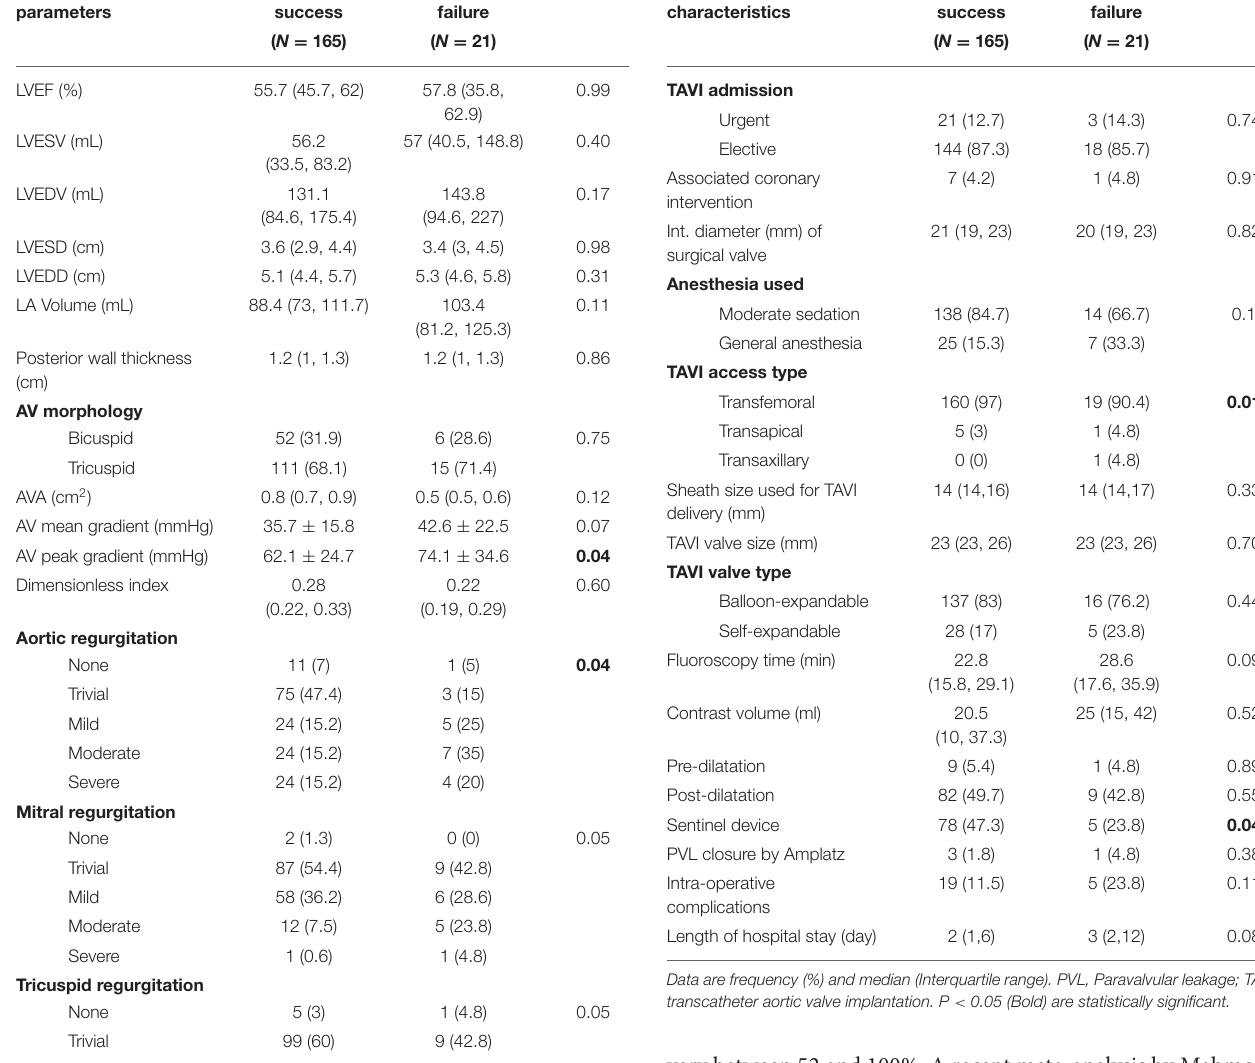
TABLE 2 | Echocardiographic parameters of patients in the procedural success and failure groups. Echocardiographic parameters